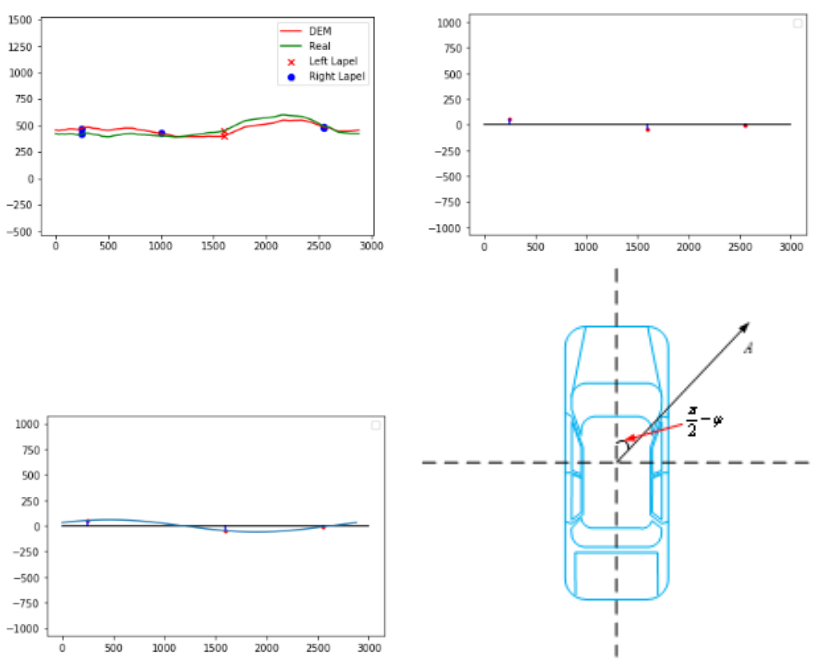
Figure 27. The camera orientation estimation process: ( Top-Left ) Find the DEM skyline lapel points matching the image lapel points (i.e., the result of coarse positioning outlined in Section 3.3.2); ( Top-Right ) calculate the difference of lapel height; ( Bottom-Left ) fit the sine curve; and ( Bottom-Right ) the physical meaning of sine function curve parameters. The variable A repre- sents the size of the superposition of roll and pitch vector in camera orientation, and the direction of the superposition.